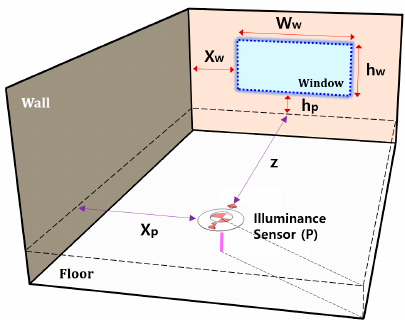
Figure 4. Room geometry for calculating the indoor horizontal illuminance.